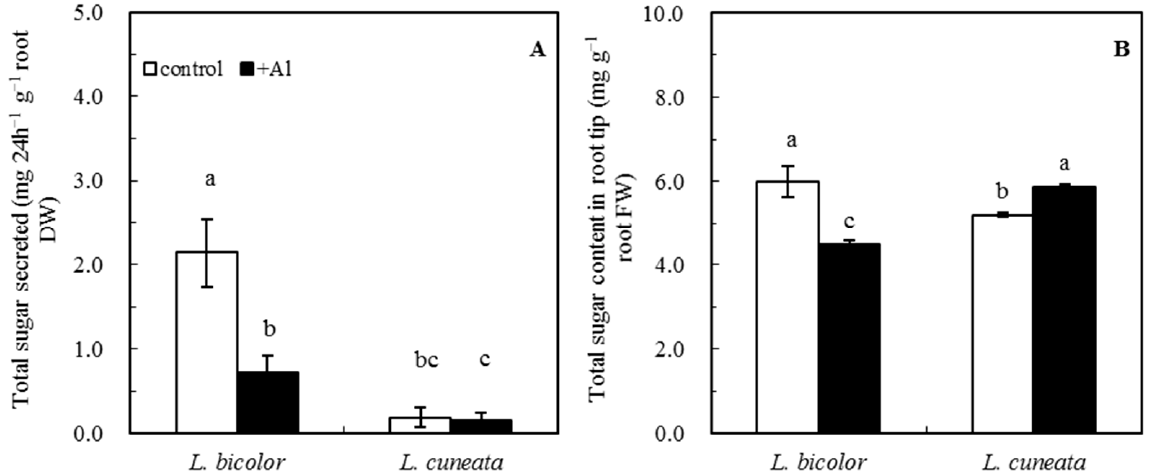
Figure 4. Effects of Al treatments on the contents of total sugar secreted from and within root tips of two Lespedeza species. ( A ) total sugar secreted from roots and ( B ) total sugar within root apices. Lespedeza seedlings were exposed to 0.5 mM CaCl 2 solutions (pH 4.5) with or without 50 μ M AlCl 3 for 24 h. Thereafter, the contents of total sugar in the culture solution and root tips (0–1.0 cm) were both determined by anthrone colorimetry. Significant differences between mean values are indicated by different letters at the p < 0.05 level (Tukey test). Values shown are means ± SD ( n = 3).